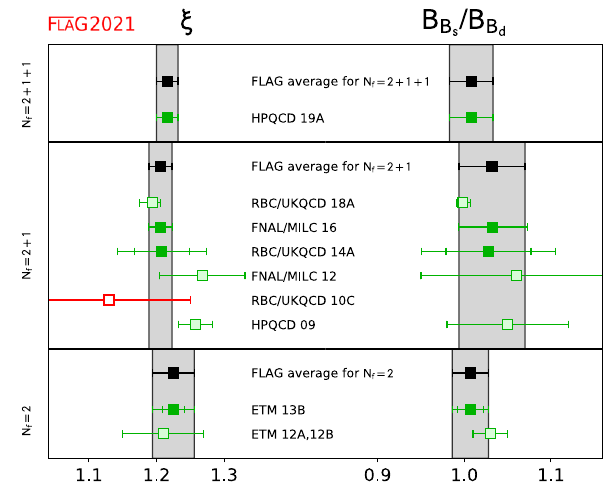
/ B B d [values in Table 44 and Eqs. (229), (232), (235)] s